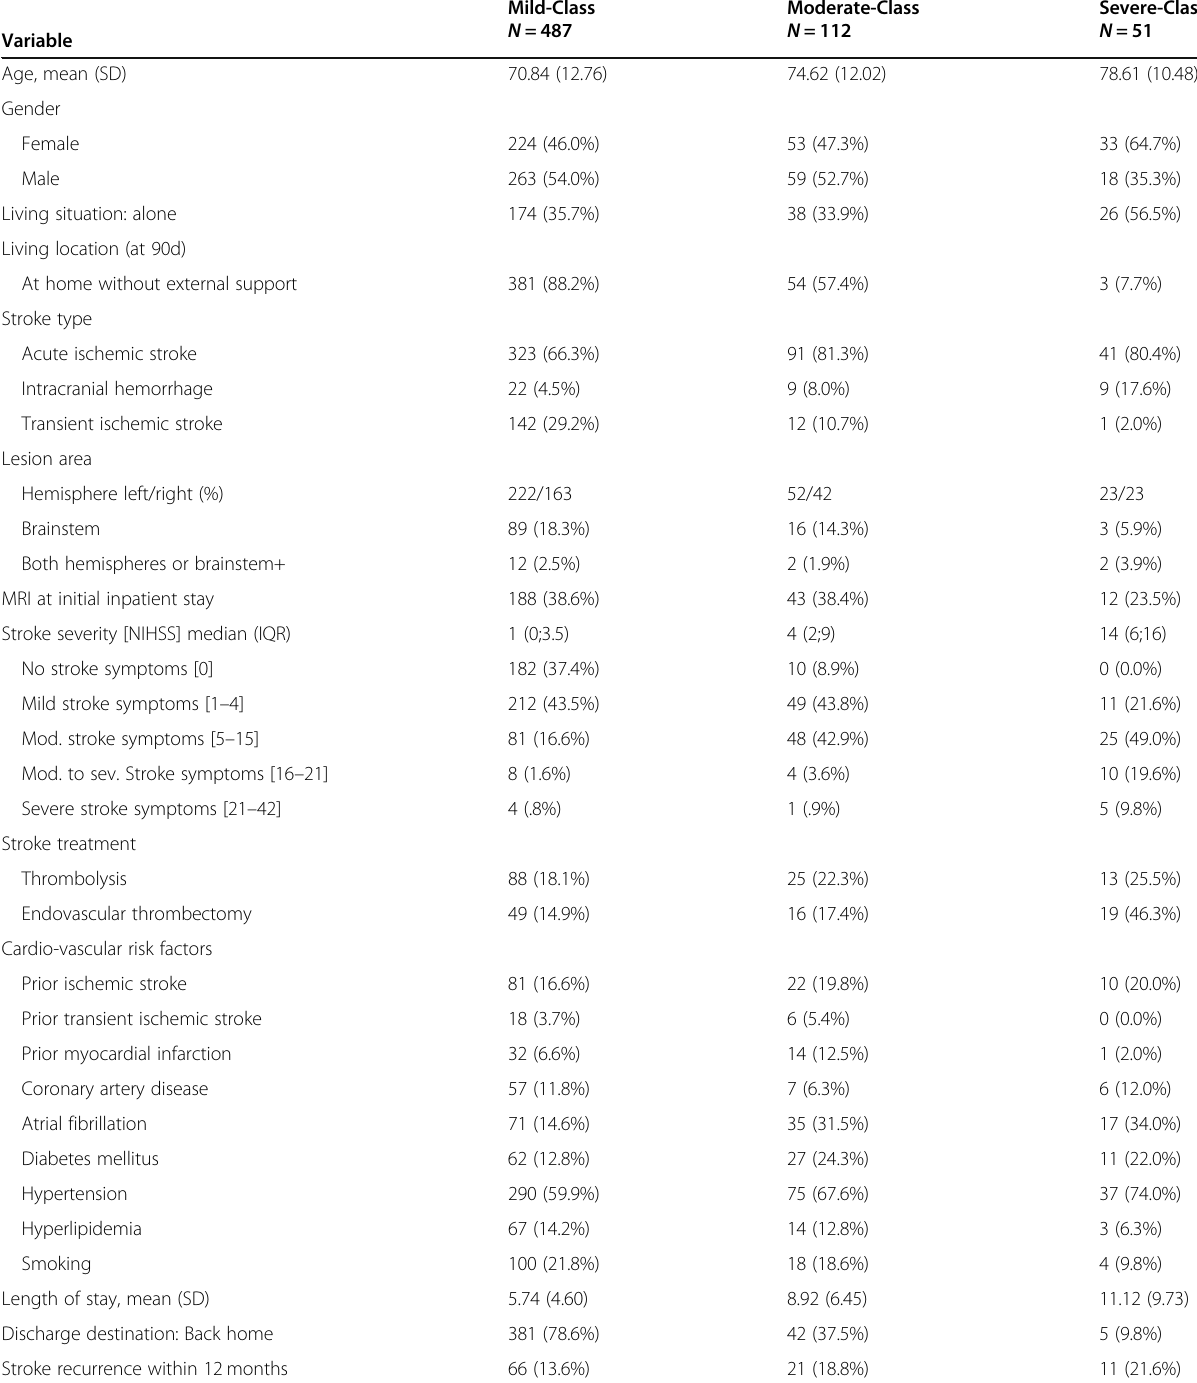
Table 1 Distribution of patients ’ characteristics in the three-class model